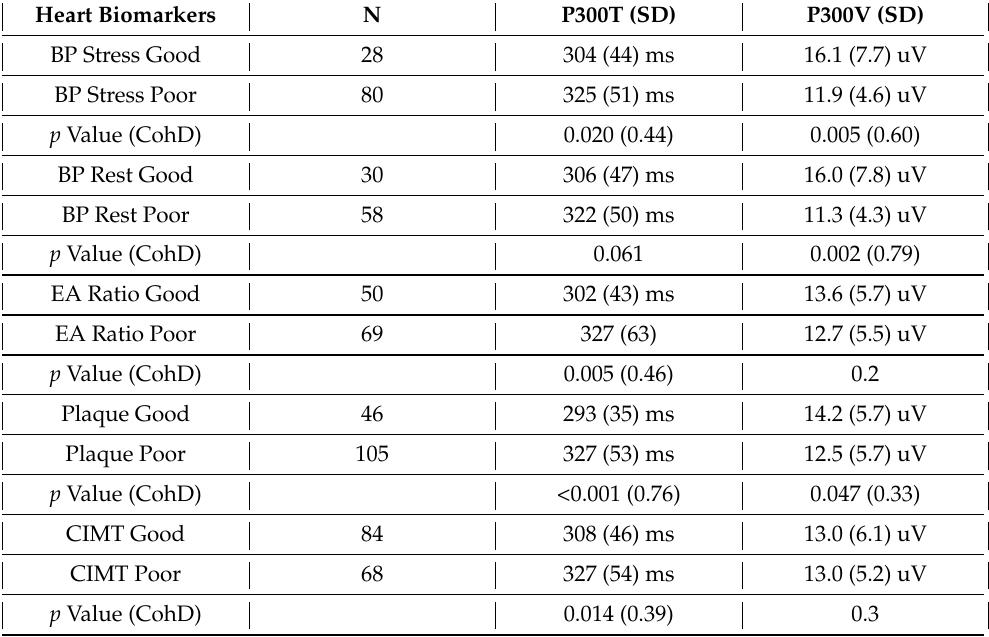
Table 2. Differences in P300 between subjects classified as good versus poor for the cardiovascular biomarkers of Table 1. Bold values represent significant differences, p < 0.05, and large effect sizes, Cohen’s D > 0.55. No effect sizes are given for non-significant